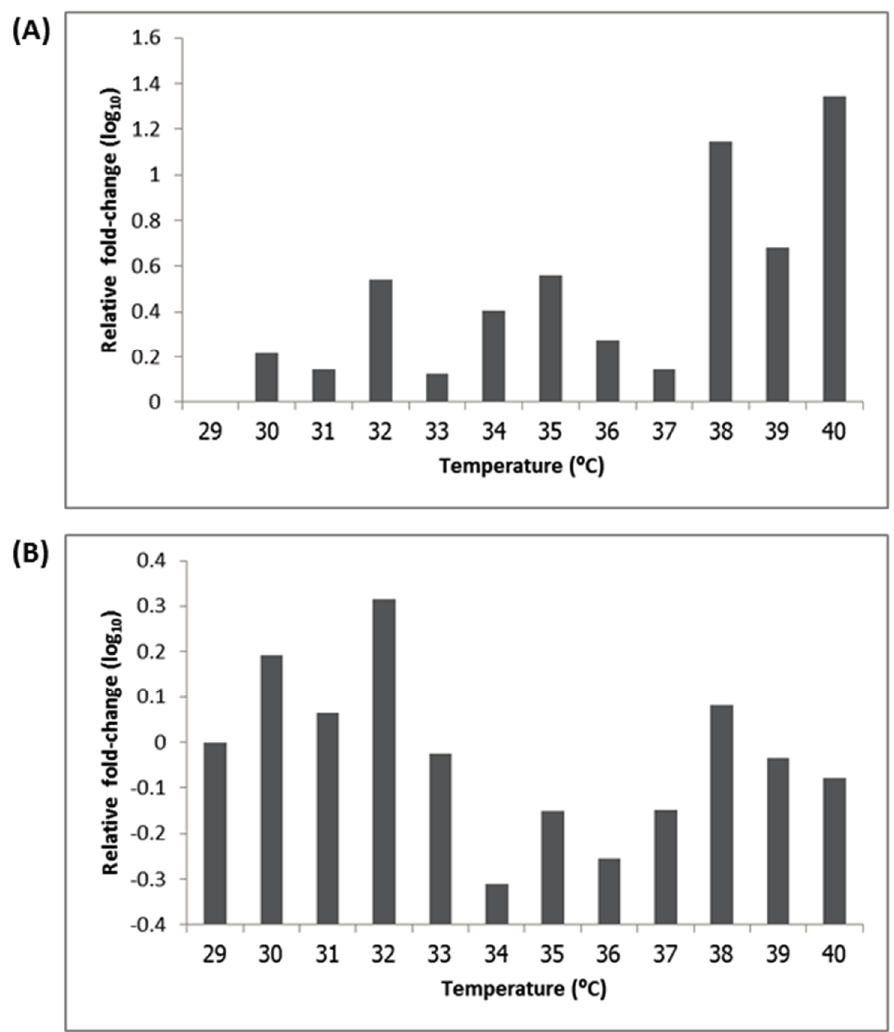
Figure 1. Relative mRNA levels at various temperatures ( A ) Relative aggA mRNA level in EAEC strain 17-2; ( B ) Relative aafA mRNA level in EAEC strain